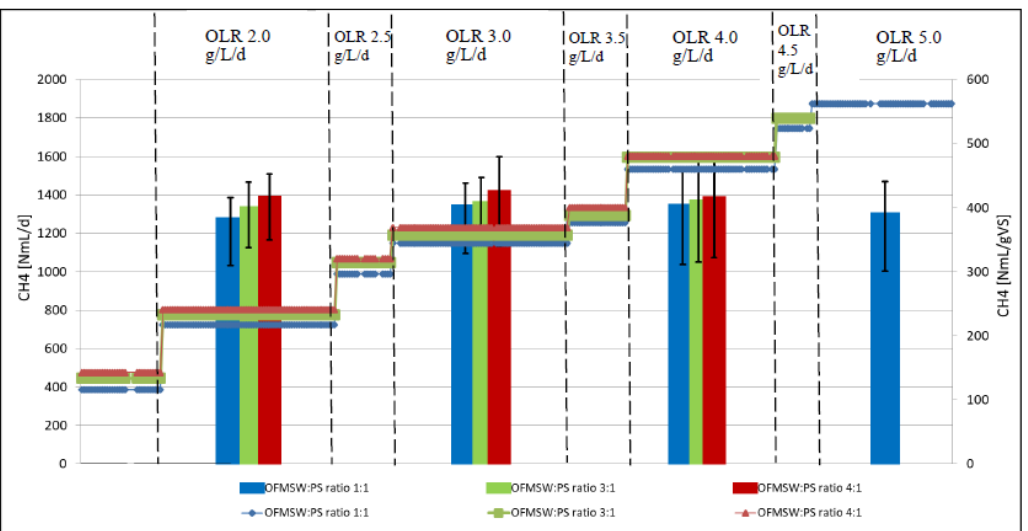
Figure 2. Daily average volumetric methane production and specific methane production during the co-digested trials, performed with di ff erent OFMSW to PS ratios. The volumetric methane production (left y-axis) during each OLR is shown as horizontal lines, and the specific methane production (right-axis) obtained at di ff erent OLRs reaching steady state conditions (i.e., OLR 2.0, 3.0, 4.0, and 5.0 g / L / d) are presented as columns.